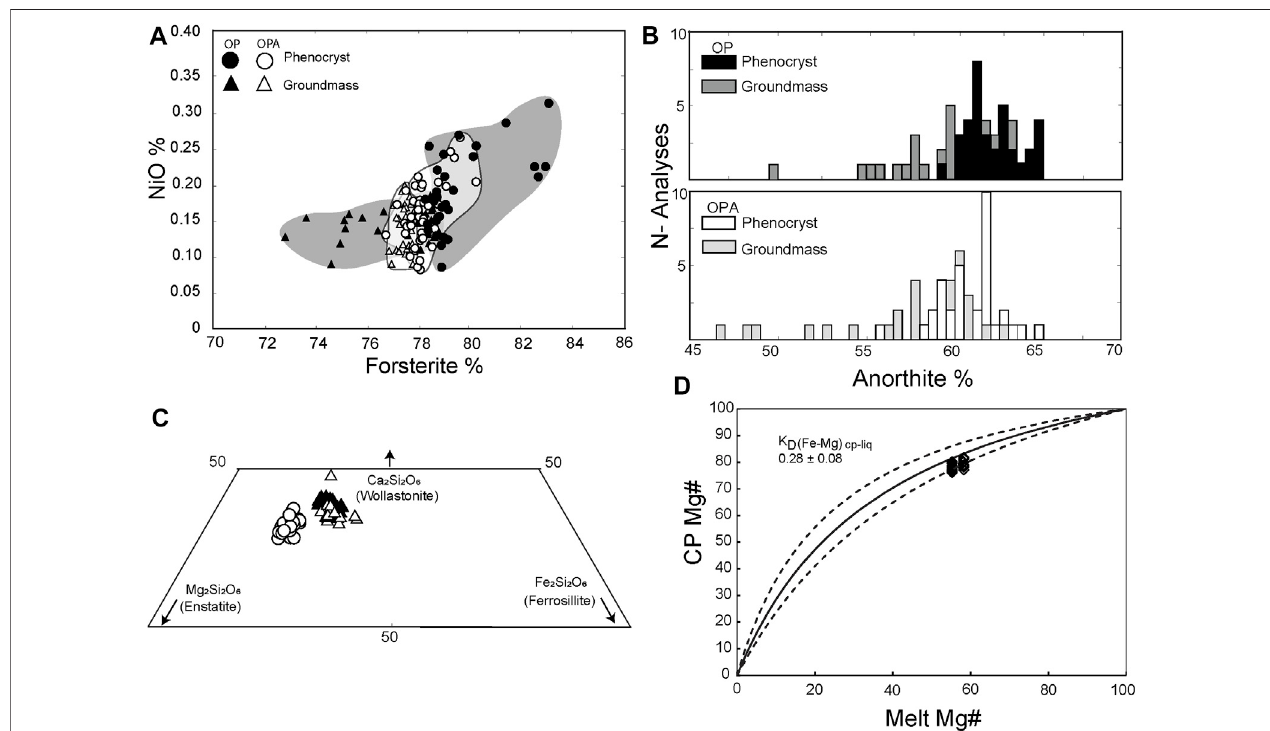
FIGURE 4 | Electron microprobe analyses of CM mineral compositions. OP phenocryst phases are shown in black (circles) and groundmass phases in black (triangles).OPAphenocrystphasesareshowninwhite(circles)andgroundmassphasesinwhite(triangles). (A) Olivineforsteritecompositions(Fo%)versusNiO wt%for OP and OPA phenocryst and groundmass phases. (B) Plagioclase Anorthite (An%) compositions for OP and OPA samples. The frequency of An% is shown on the vertical axis of the bar charts. (C) Clinopyroxene classi fi cations (after Morimoto, 1988) for OPA phenocrysts and OP and OPA groundmass phases. OPA phenocrysts are all high-Ca augite, and both OPA and OP groundmass phases plot along the augite-diopside boundary. (D) Equilibrium constants (K D ) calculated from Putirka (2008) for OPA clinopyroxene and plotted against the predicted range for crystals formed under equilibrium conditions (0.28). Dashed lines indicate the 2s uncertainty on the mean K D value (i.e., ±